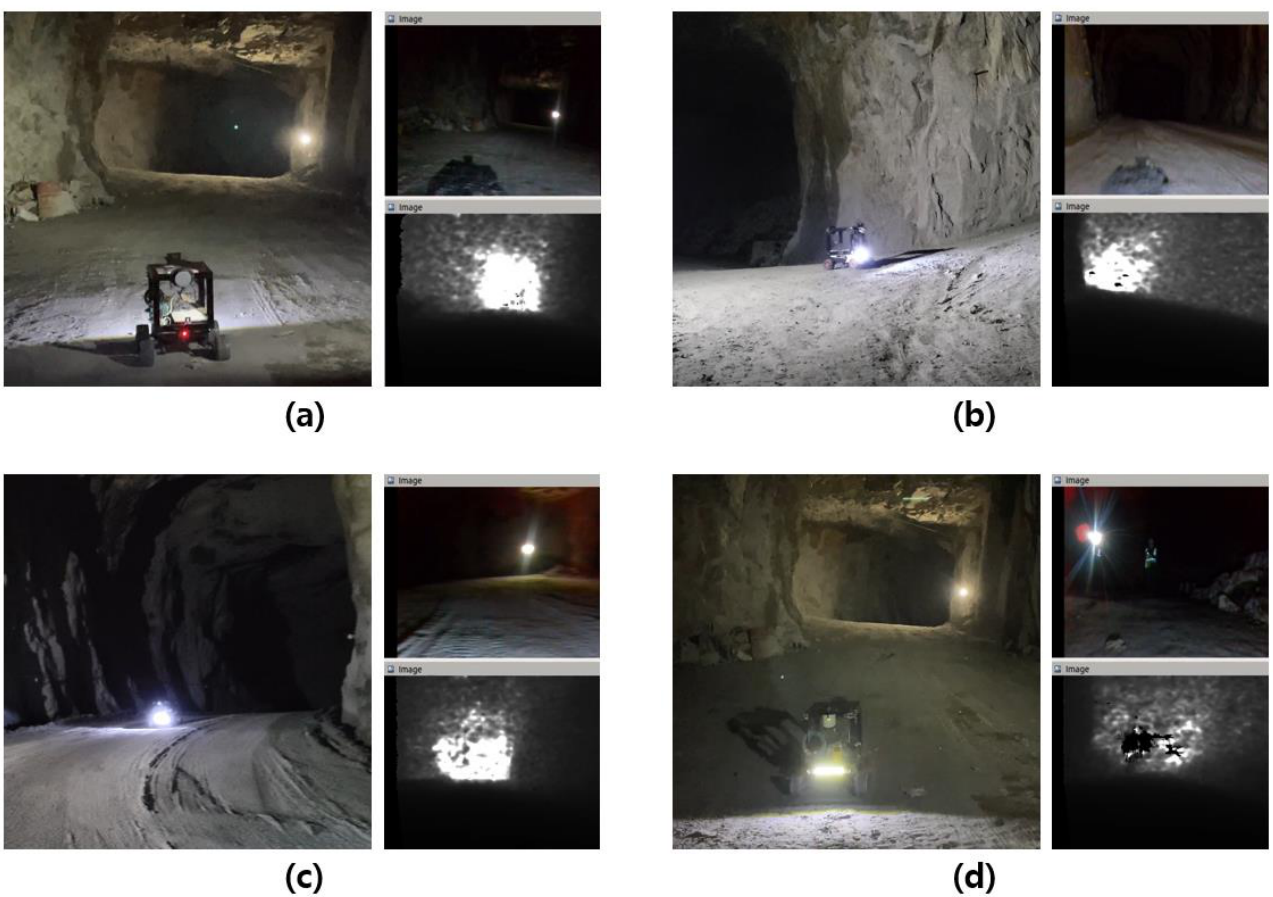
Figure 10. View of the autonomous driving robot, RGB image, depth image at the ( a ) starting point, ( b ) intersection, ( c ) destination, and ( d ) arrival point.